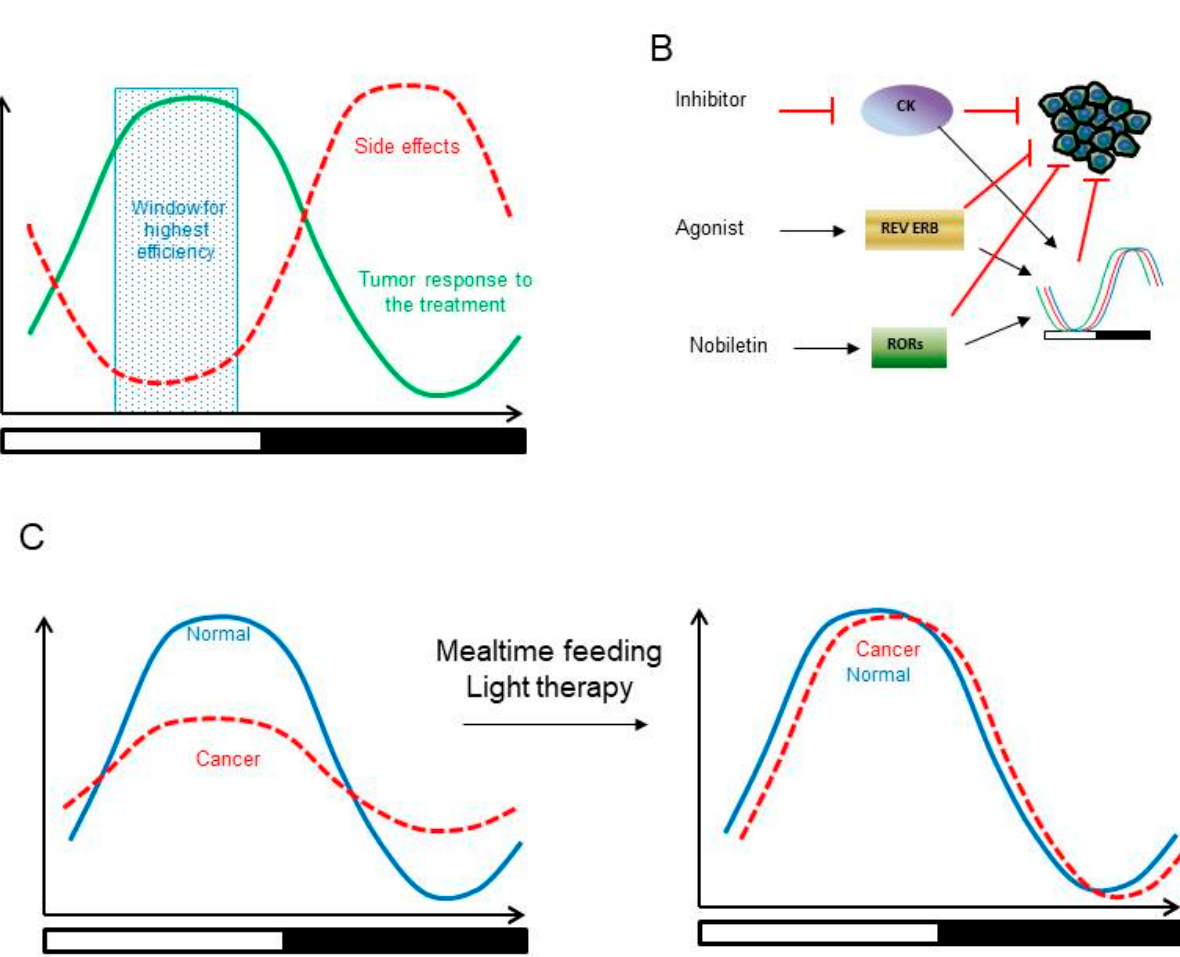
Figure 4. Circadian approaches to cancer treatment. ( A ) Chronotherapy of cancer. Tumor response to treatments, such as chemotherapy or irradiation, is time-of-day dependent. Toxic side effects are also influenced by the rhythms. Knowledge on both rhythms will help to identify a time window for the most efficient treatment. ( B ) Targeting circadian clock proteins directly, RORs or REV-ERBs, or indirectly, CK2, with small molecules impacts the tumor either through the circadian clock and rhythms or through clock-independent tumor suppressor functions of clock proteins. ( C ) Restoring the circadian rhythms using environmental cues, such as time restricted feeding or light exposure, could be beneficial for prevention and treatment of cancer.